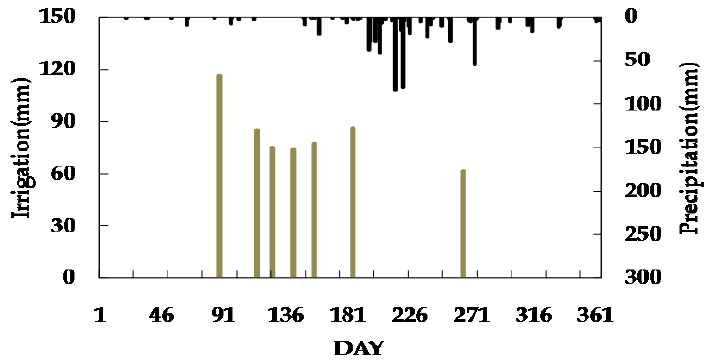
Figure 12. Precipitation and simulated irrigation under Scenario 1 in 1974.